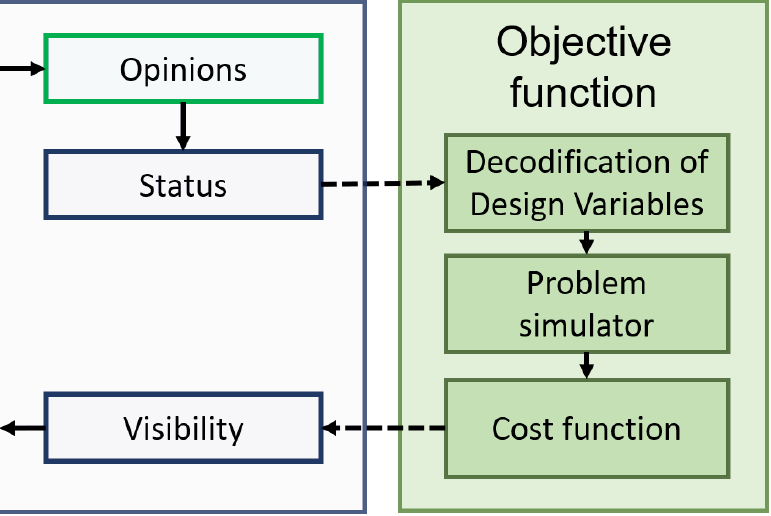
Figure 2. Details of the post-evaluation